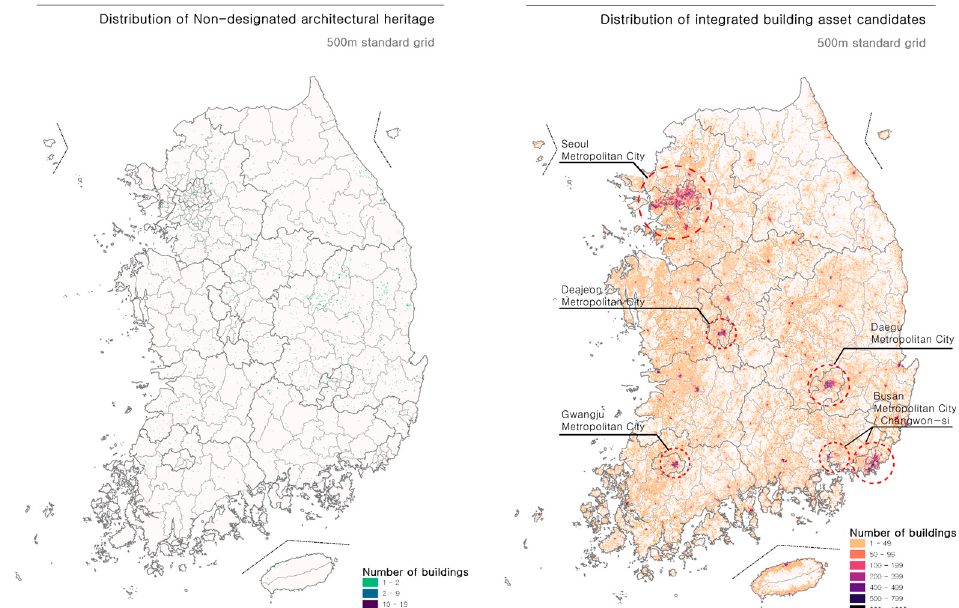
Figure 3. Distribution of architectural assets candidates.